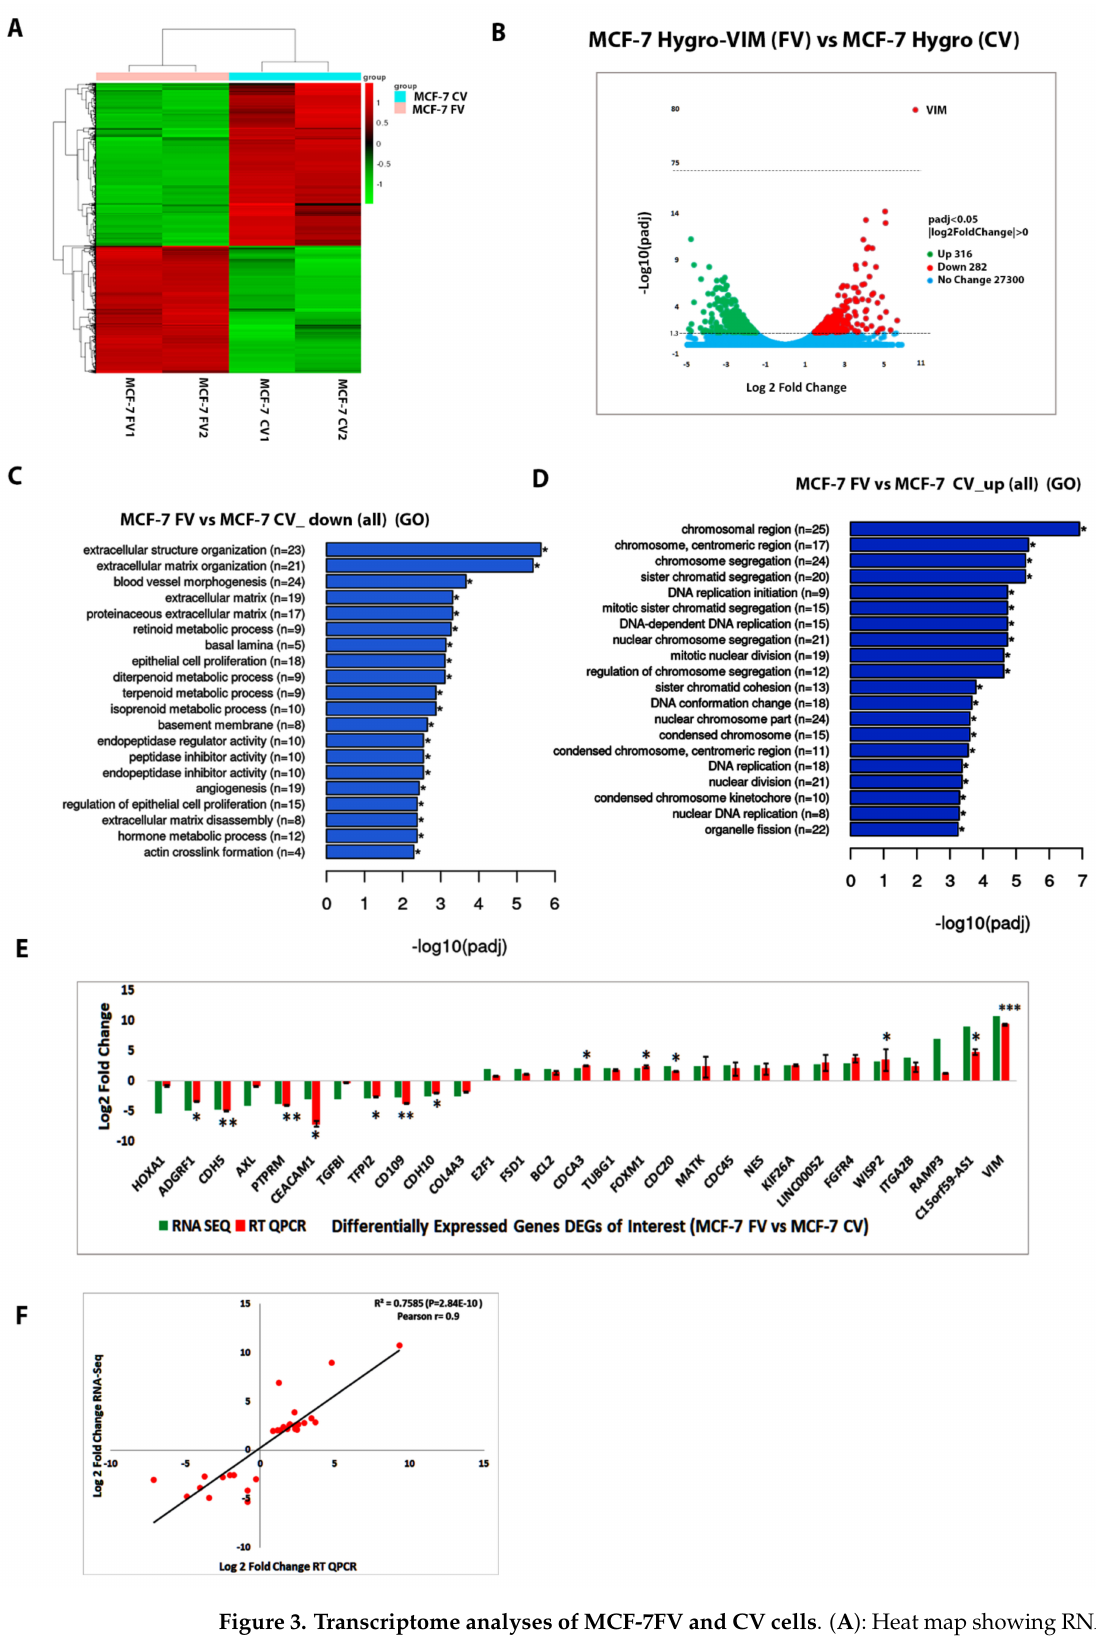
Figure 3. Transcriptome analyses of MCF-7FV and CV cells . ( A ): Heat map showing RNA-Seq tran- scriptome analysis in duplicate samples of MCF-7hygro-VIM (FV) and MCF-7hygro (CV) ( B ): Volcano plot showing the overlapping genes and DEGs between MCF-7FV and CV. The dotted line